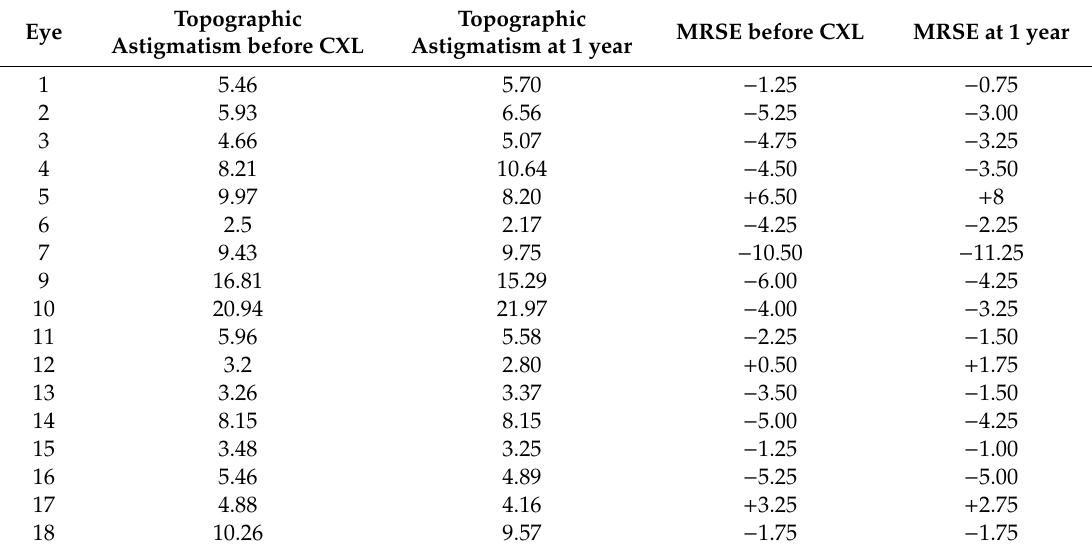
Table 1. Topographic astigmatism and manifest refraction spherical equivalent